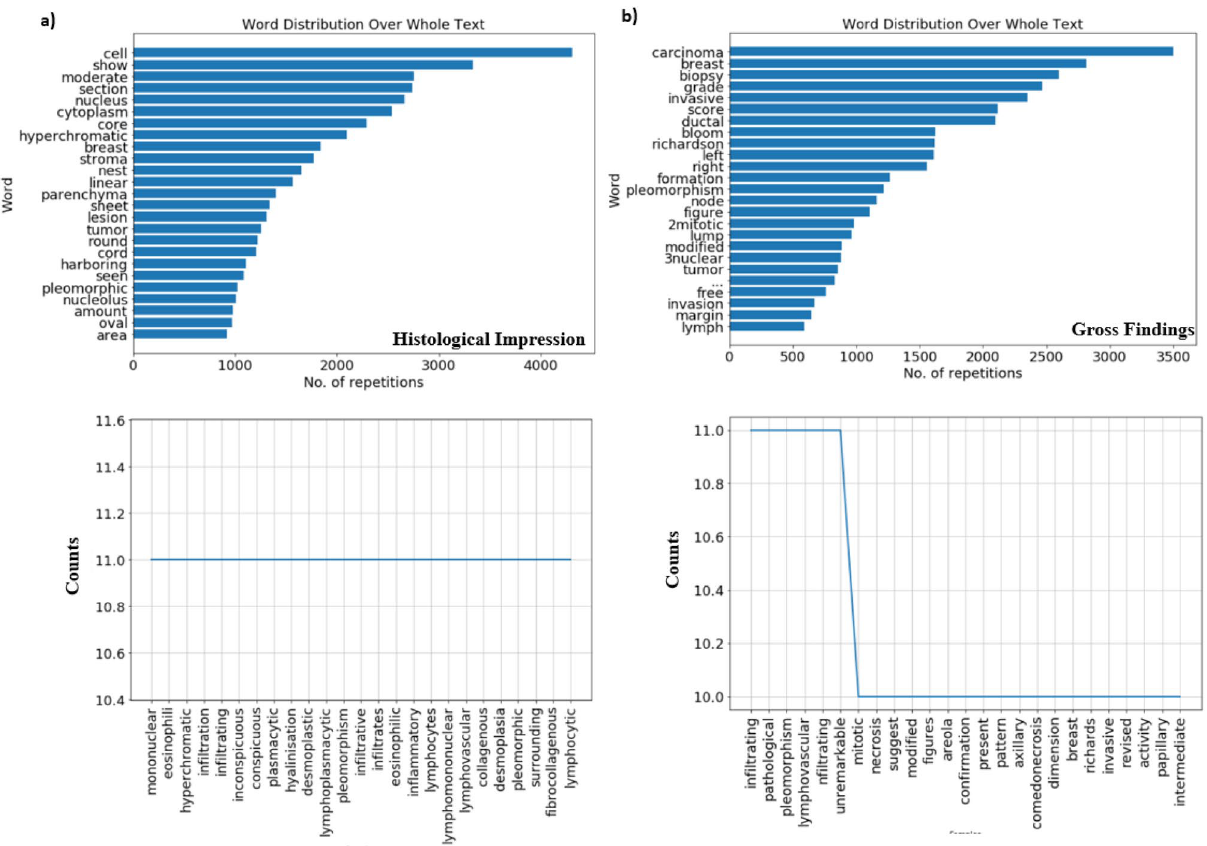
Figure 3. Text Mining and Knowledge Discovery of clinical data ( a and b ) the upper panel describes word distribution over the histological impression and gross findings. The bottom panel represents words with a frequency count above 10 and a length of more than 5